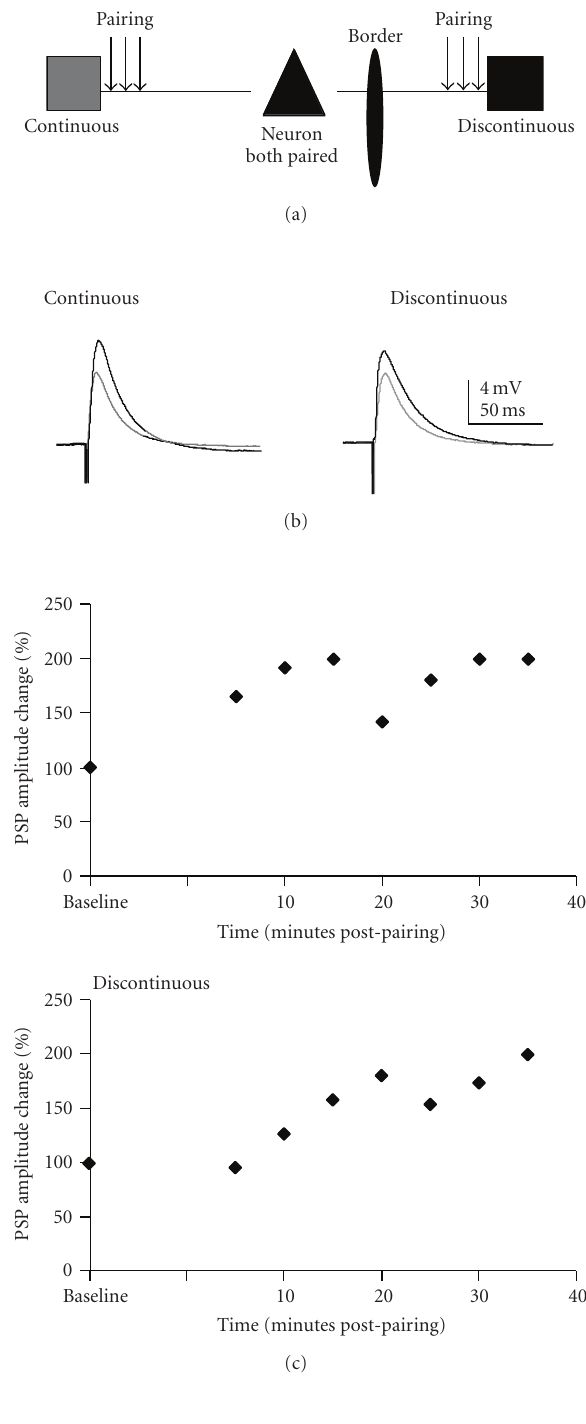
Figure 3: LTP induced by a pairing paradigm given to both con- tinuous representation and discontinuous representation pathways. (a) Schematic drawing of the pairing protocol. Both pathways are paired alternately to induce synaptic plasticity. (b) Example of PSPs from a cell where both pathways underwent LTP. Gray traces are averaged baseline PSPs. Black traces are averaged traces 20 minutes postpairing. Traces are averaged over 5 minutes (15 traces) for both pre- and postpairing PSPs, (c) % change of PSP amplitude over time for the cell shown in 2. PSP amplitude change was averaged over five minute